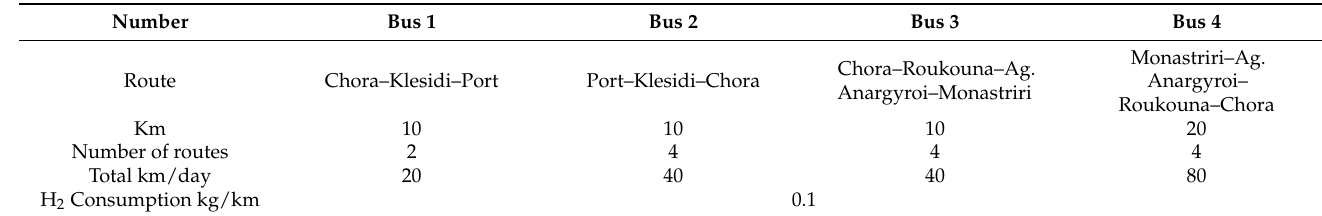
Table 2. All the bus routes that operate on the island of